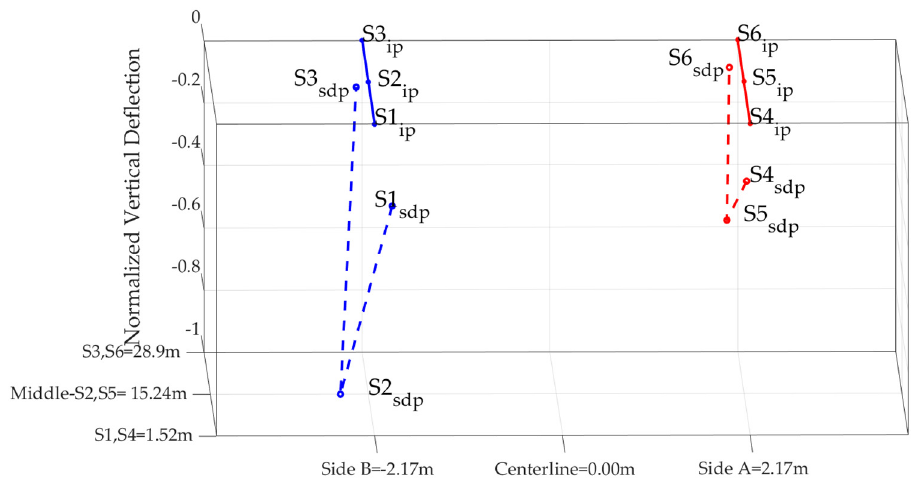
Figure 19. 3rd Identified mode shape—lateral with sensor 4 as reference at 4.57 Hz.